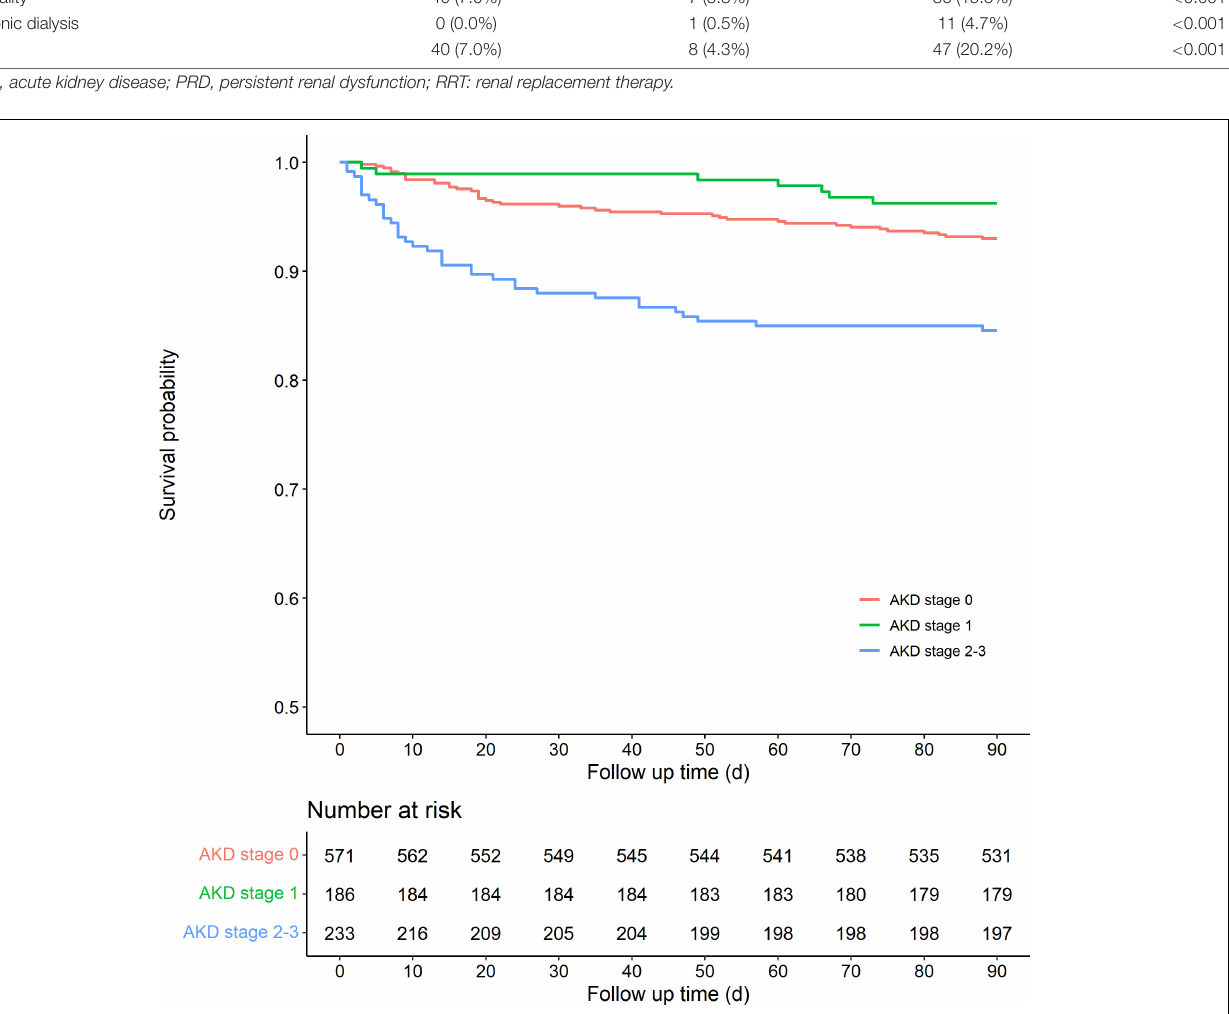
FIGURE 2 | Kaplan–Meier survival curves for 90 days mortality among AKD stages. The overall p- value was < 0.001 among the three groups. The p- value for pairwise comparison was 0.112 between AKD stage 0 and AKD stage 1, < 0.001 between AKD stage 0 and AKD stage 2–3 and between AKD stage 1 and AKD stage 2–3. AKD, acute kidney